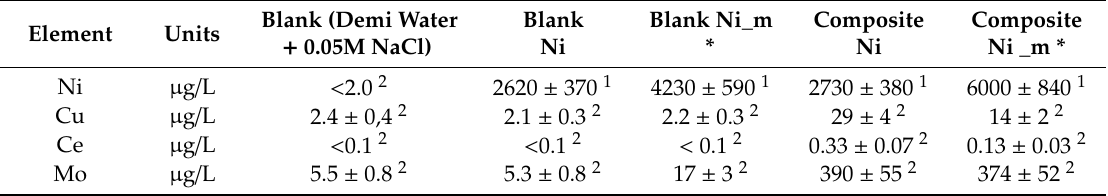
Table 5. Concentrations of Ni, Cu, Ce, and Mo in a corrosive solution.